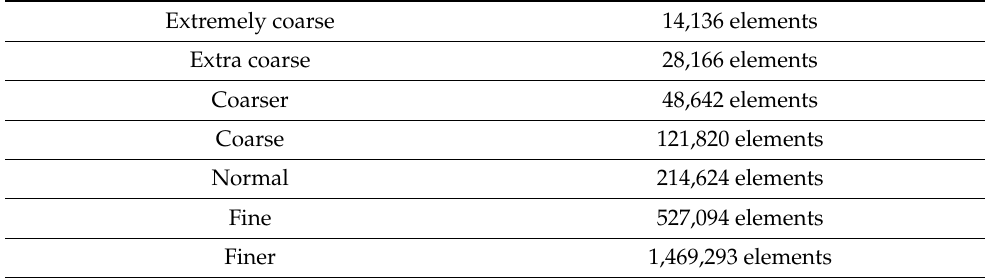
Table 2. Mesh information for a different level of meshing